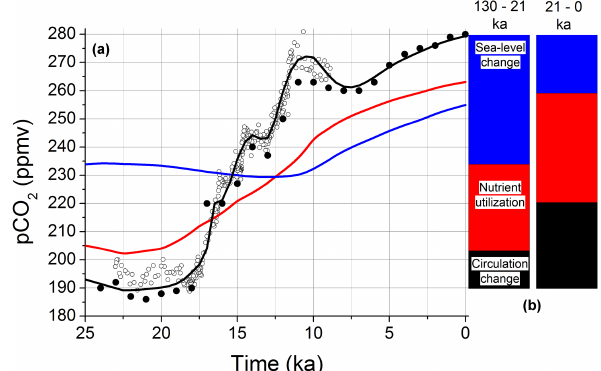
Figure 7. Atmospheric p CO 2 over the last 25kyr. (a) Model re- sults for simulations STD (black line), STD-CC (red line), and STD-CC-CN (blue line); solid dots indicate ice-core data by Mon- nin et al. (2001, 2004) while ice-core data reported in Marcott et al. (2014) are shown as open circles; (b) relative contribution of sea- level change (blue), nutrient utilization (red), and ocean circulation changes (black) to p CO 2 model results; the left-hand column shows contributions to the glacial p CO 2 drawdown (51% induced by sea- level fall, 34% by enhanced nutrient utilization, 15% by changes in ocean circulation); the right-hand column indicates the driving forces for the deglacial p CO 2 rise (23% induced by sea-level rise, 43% by decrease in nutrient utilization, 34% by changes in ocean